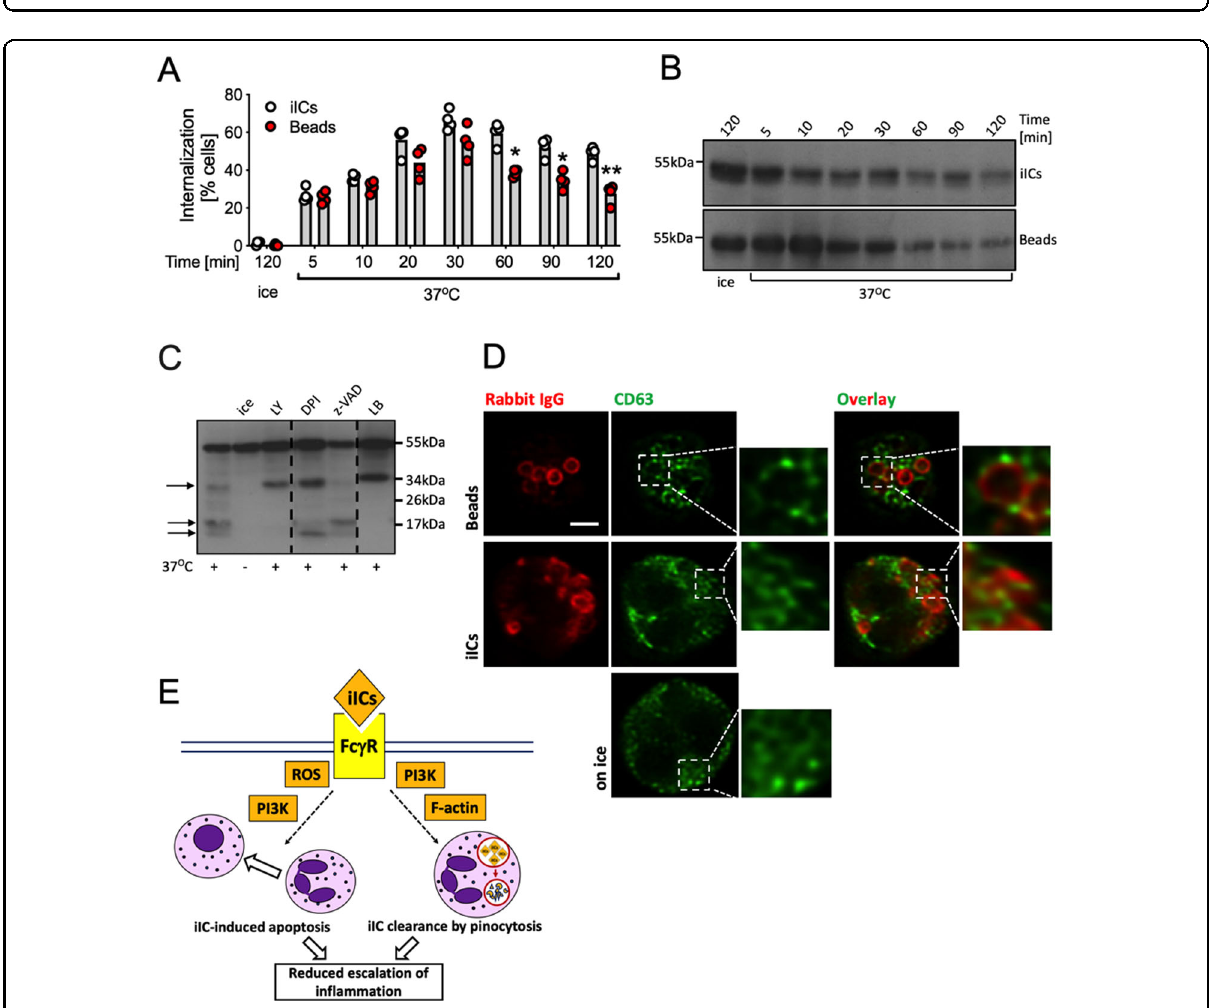
Fig. 8 Internalized iICs are subject to rapid degradation. A Suspension neutrophils at 37°C or on ice were stimulated with 2 μ g/ml iICs or 5 IgG- opsonized beads/neutrophil for the indicated times, allowed to attach to glass slides on ice, fi xed, and labelled for external and total particles. Cells containing internalized particles are plotted. Each symbol represents the average value obtained in a separate experiment. Data were analyzed by two-way ANOVA with multiple comparisons post-hoc test; * p <0.05; ** p <0.01. Neutrophils were stimulated with 2 μ g/ml iICs for the indicated time at 37°C or on ice ( B ), or after being pre-incubated with inhibitors or vehicle as indicated to inhibit PI3K, ROS production, caspases and actin polymerization ( C ; LY, LY294002; DPI diphenyleneiodonium, z-VAD z-VAD-FMK, LB latrunculin B, respectively). Cell lysates were subjected to SDS-PAGE, transferred to PVDF membrane and probed for the rabbit IgG heavy chain. Representative blots are shown from ≥ 3 separately performed experiments. D Neutrophils were or were not stimulated with iICs or IgG-opsonized beads as in ( A ), and allowed to adhere to glass slides prior to labelling CD63 and rabbit IgG. Samples were viewed on a Leica SP8 confocal microscope with 63× objective. Representative examples are shown. Scale bar, 2 μ m. E Schematic diagram illustrating the two concomitant iIC-induced neutrophil anti-in fl ammatory pathways, iIC macropinocytosis and iIC-induced neutrophil